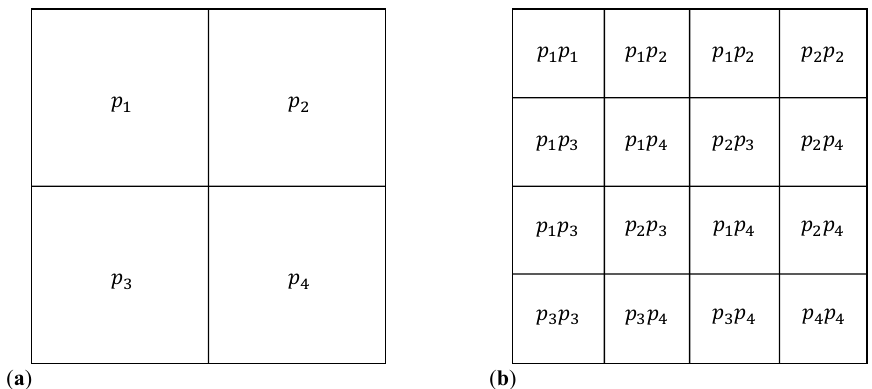
Figure 1. The initiator ( a ) and generator ( b ) of the multifractal lattice. The quantities p 1 , p 2 , p 3 and p 4 represent the probabilities associated with their corresponding cells in the